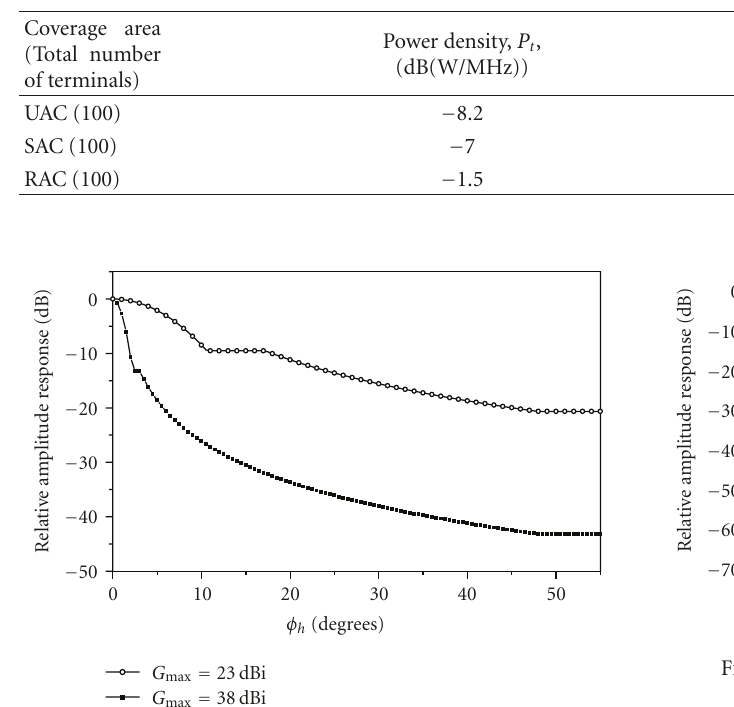
Figure 3: Antenna beam patterns for the HUT.